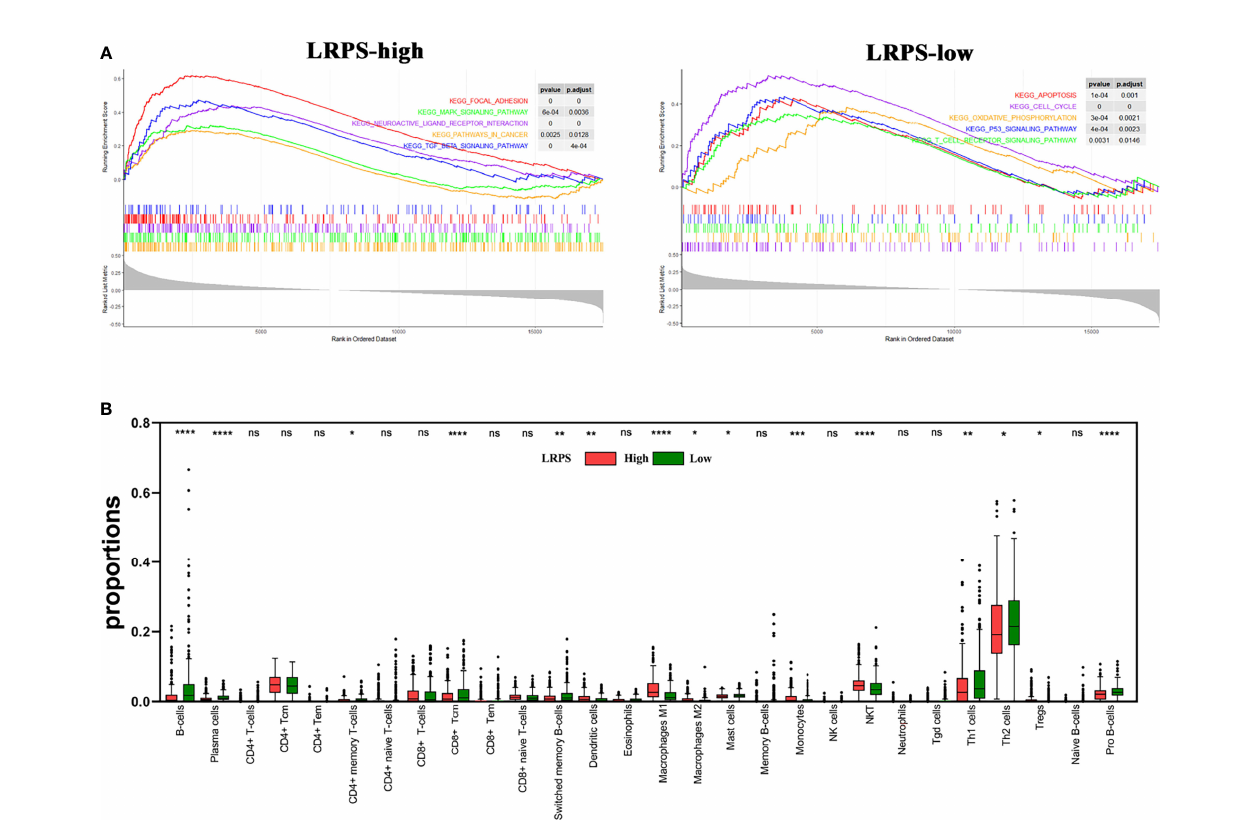
FIGURE 7 | Molecular characteristics of LPRS subgroups. (A) Gene sets enrichment in the LRPS-high and LRPS-low groups, respectively ( p < 0.05, FDR < 0.25). (B) The proportions of immunocytes within tumor microenvironment in different LRPS subgroup (ns, no signi fi cance; * p < 0.05; ** p < 0.01; *** p < 0.001; **** p < 0.0001). NK cells, natural killer cells; NKT, natural killer T cells; Tgd cells, gamma delta T